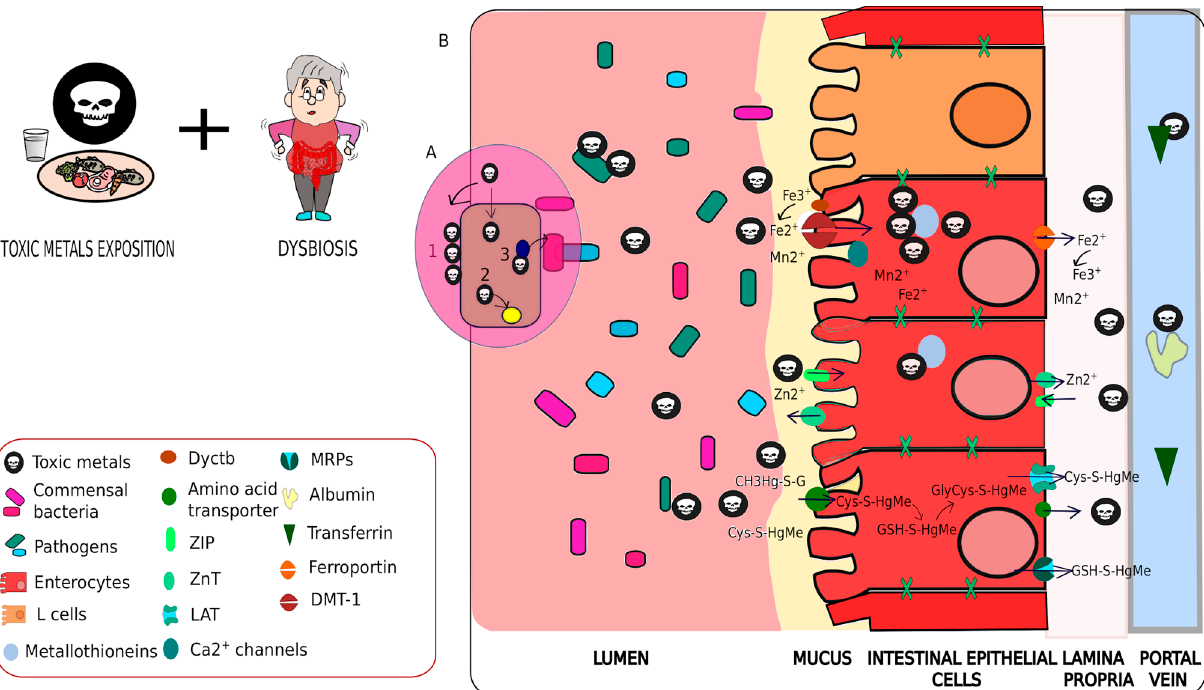
Figure 4. Gut–microbiome metal uptake. ( A ) Mechanisms of microbial heavy metal